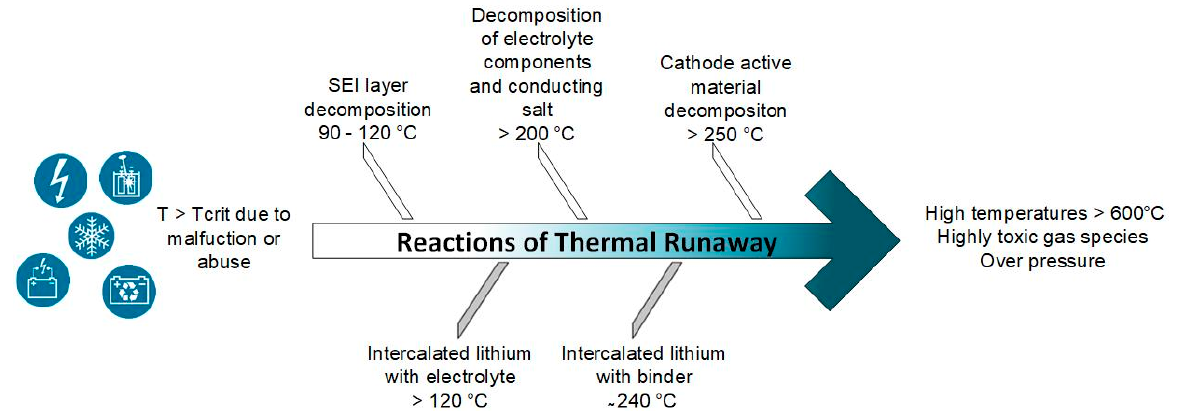
Figure 4. Schematic sequence of thermal runaway between different battery cell components after a critical cell temperature has been exceeded.